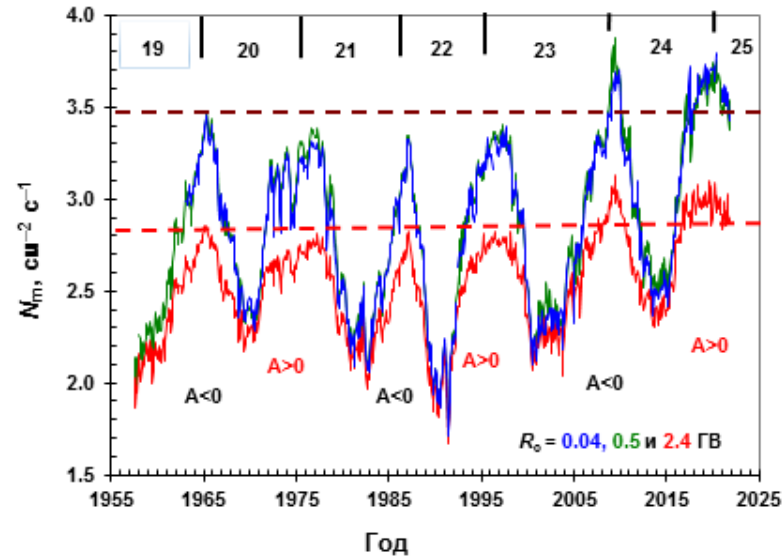
Figure 1. Time dependence of CR fluxes ( N m , monthly averages) in the 19–25 solar activity cycles (shown as the numbers at the top of the figure). These data were obtained at the northern polar latitude (green curve, R c = 0.5 GV; Murmansk region, Apatity station), at the southern polar latitude (blue curve, station Mirny in the Antarctica, R c = 0.04 GV), and at the middle northern latitude (red curve, R c = 2.4 GV; Moscow station). The dashed brown and red lines represent the maxima of CR fluxes observed in 1965 at these latitudes. The values A > 0 and A < 0 show the phases of the 22-year solar magnetic cycle: A > 0 is the positive phase and A < 0 is the negative one (see text for detail).